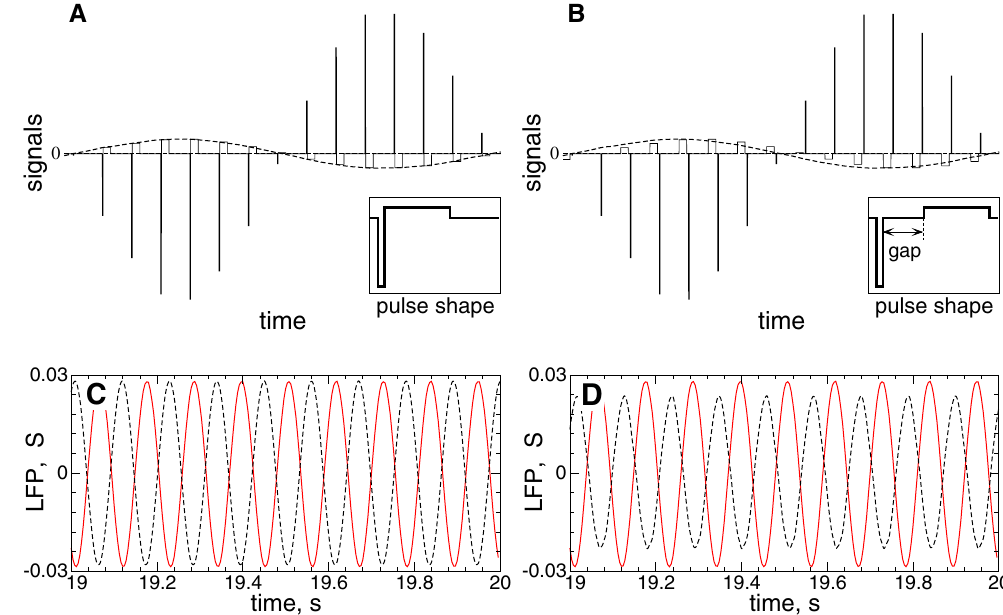
Figure 3. Stimulation signals of pulsatile delayed feedback. ( A ), ( B ) The amplitude of the high-frequency pulse train of charge-balanced asymmetric biphasic pulses (solid lines) is modulated by a slowly oscillating smooth signal S ( t ) of LDF (6) or NDF (7) depicted by dashed curves. The corresponding shape of a single pulse is schematically depicted in the inserts. In plot ( B ) the stimulation pulses contain an interphase gap between the cathodic and anodic phase of the pulse. ( C ), ( D ) Filtered LFP (red solid curves) from Fig. 1B and the corresponding feedback signals S ( t ) (black dashed curves) of ( C ) LDF and ( D ) NDF calculated from the LFP by means of equations (6) and (7), respectively. Stimulation delay τ = 50 ms, and the stimulation intensities ( C ) K = 0.5 and ( D ) K =